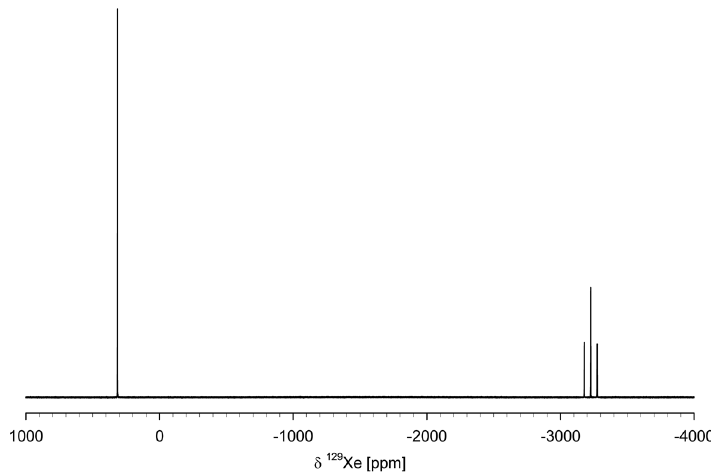
Figure 3. Example of 129 Xe NMR spectrum: 319 ppm – averaged signal of Xe(0) (ligand 3a , [L]/[Xe] = 9.95, in CDCl ( 1 J = 5640 XeF